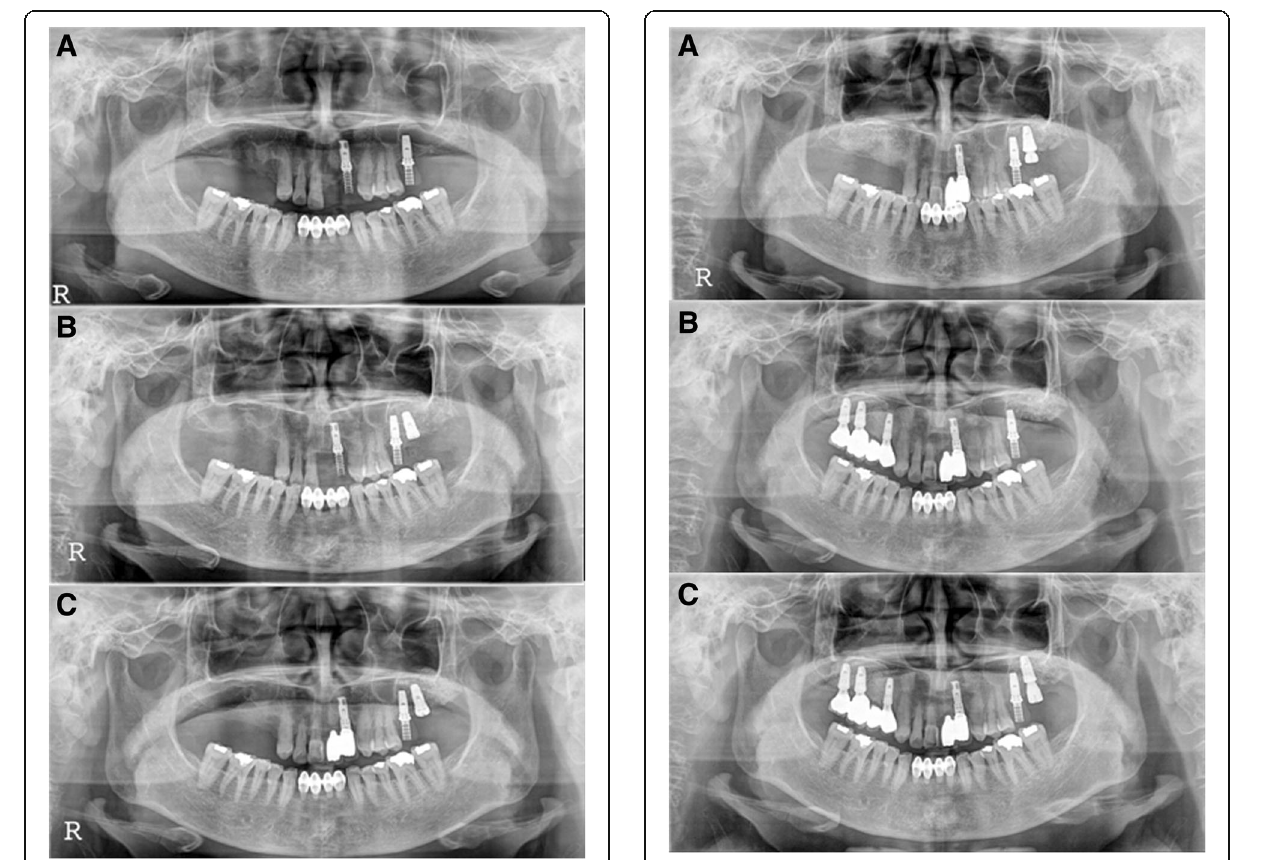
Fig. 6 F2, Panoramic radiograph, #27i surgery a initial panoramic radiograph, b postoperative panoramic radiograph, c #27i second operation